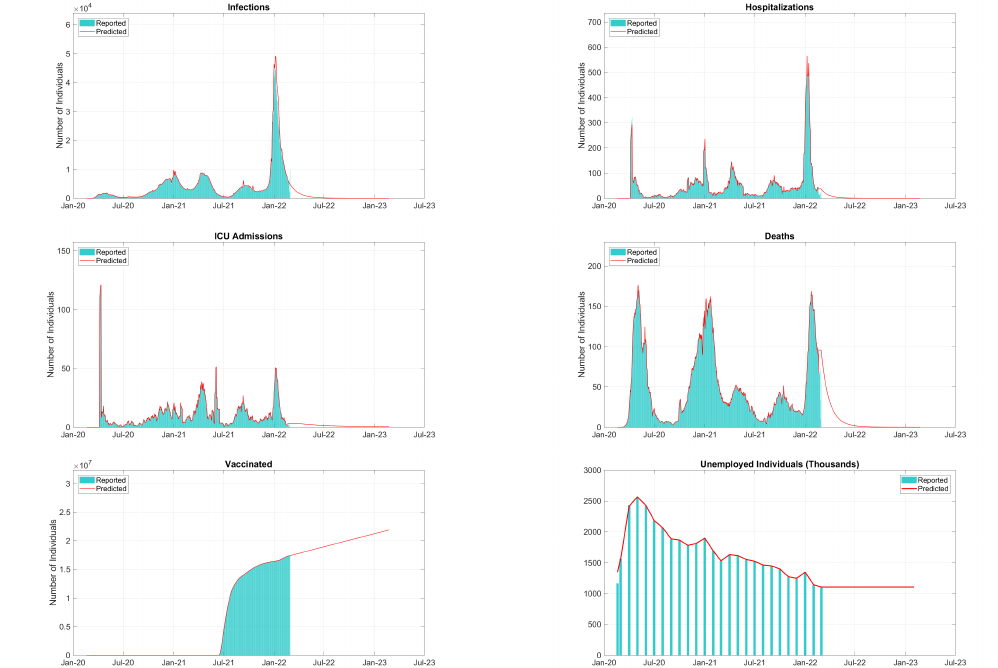
Figure 4. Reported (blue area) seven-day moving average of daily COVID-19 infections, hospitaliza- tions, ICU admissions, and deaths, as well as the monthly number of unemployed individuals, and their corresponding model predictions (solid lines) for